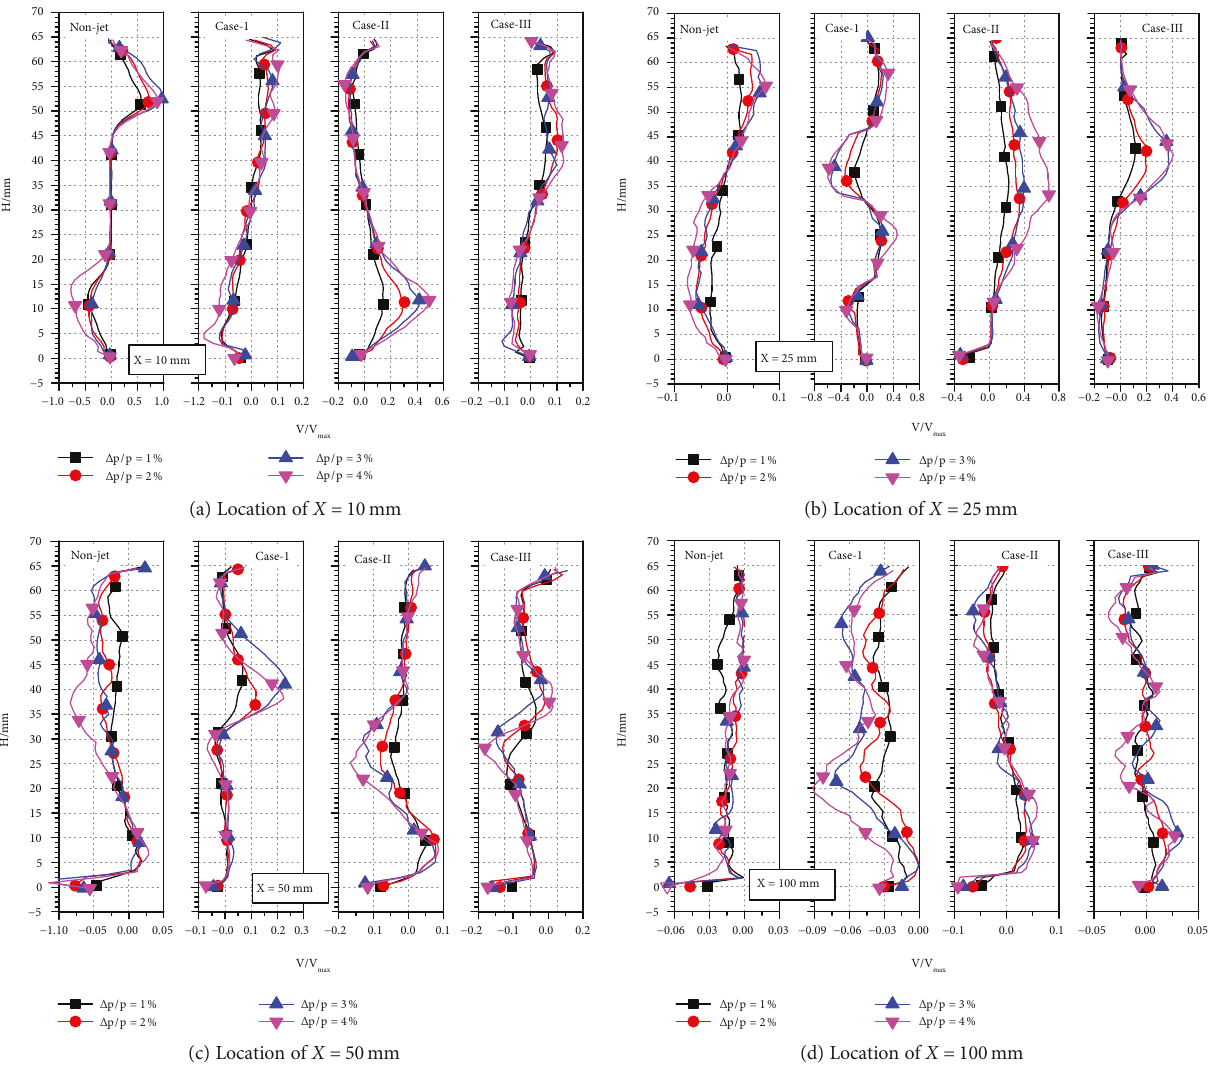
Figure 5: Radial velocity along the Y direction at di ff erent axial locations on the Z = 0